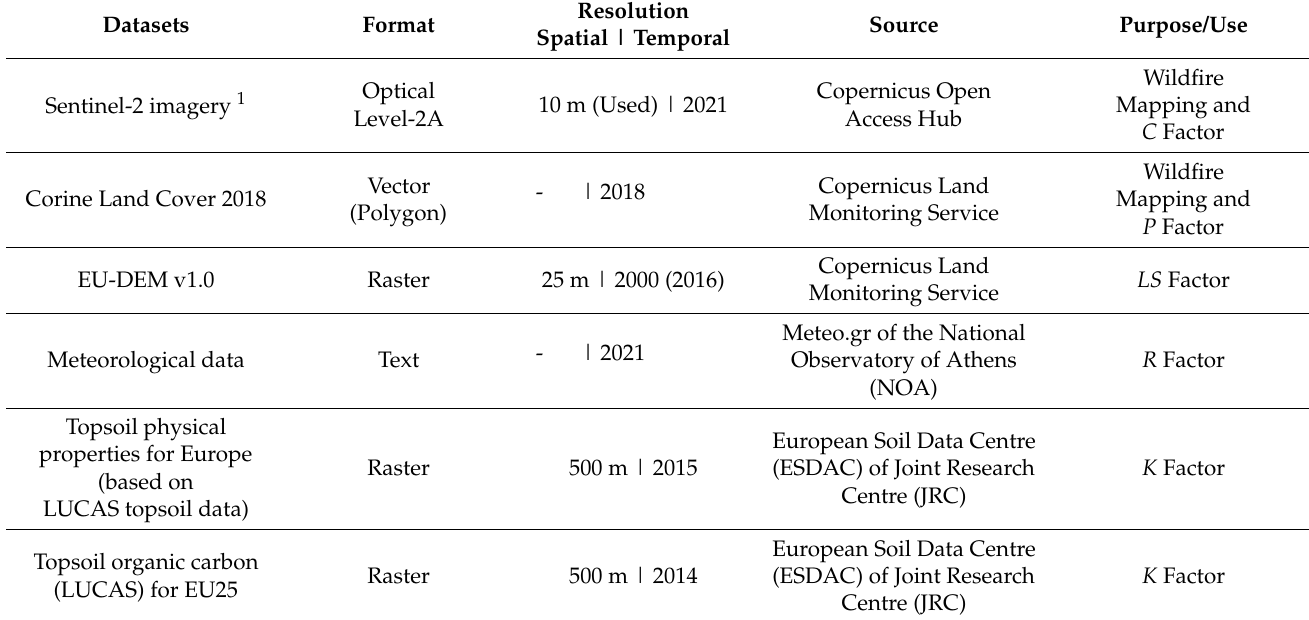
Table 1. Utilized